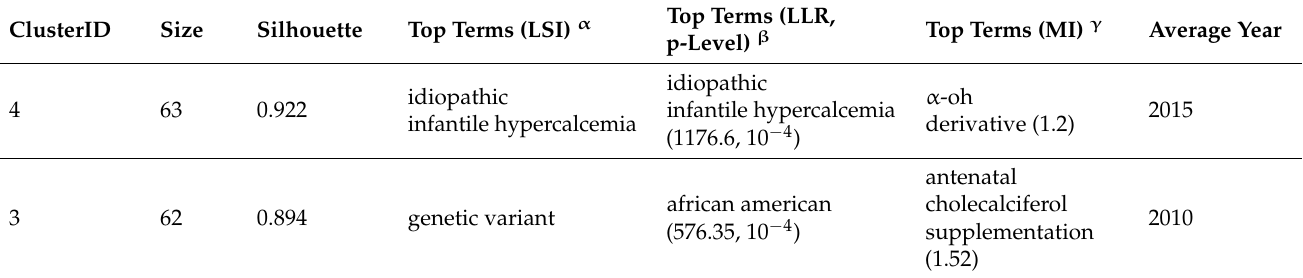
Table 2. Summary of the largest 19 clusters of vitDMGPs articles with top terms mentioned